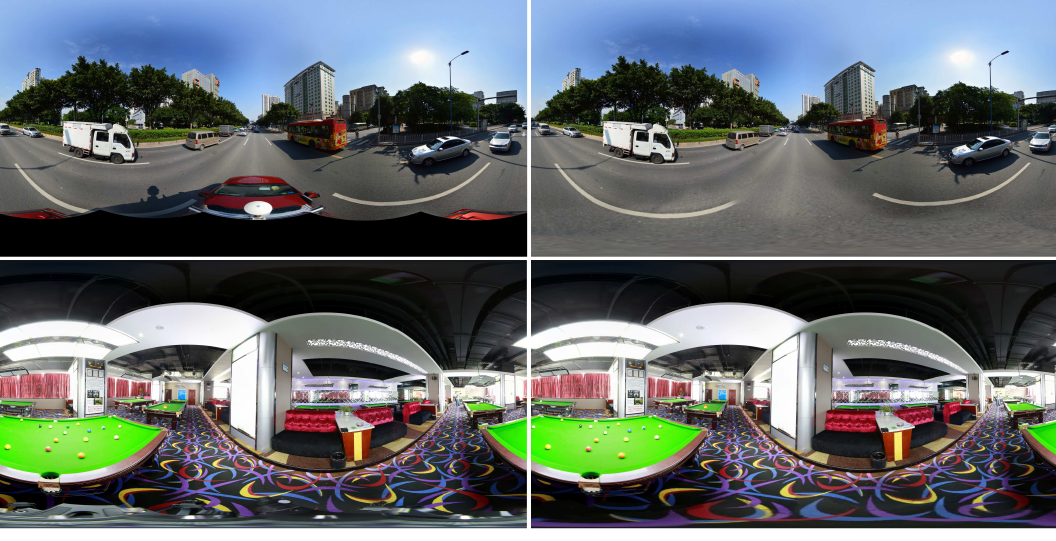
Figure 14. Two finally completed panoramas by our proposed unified